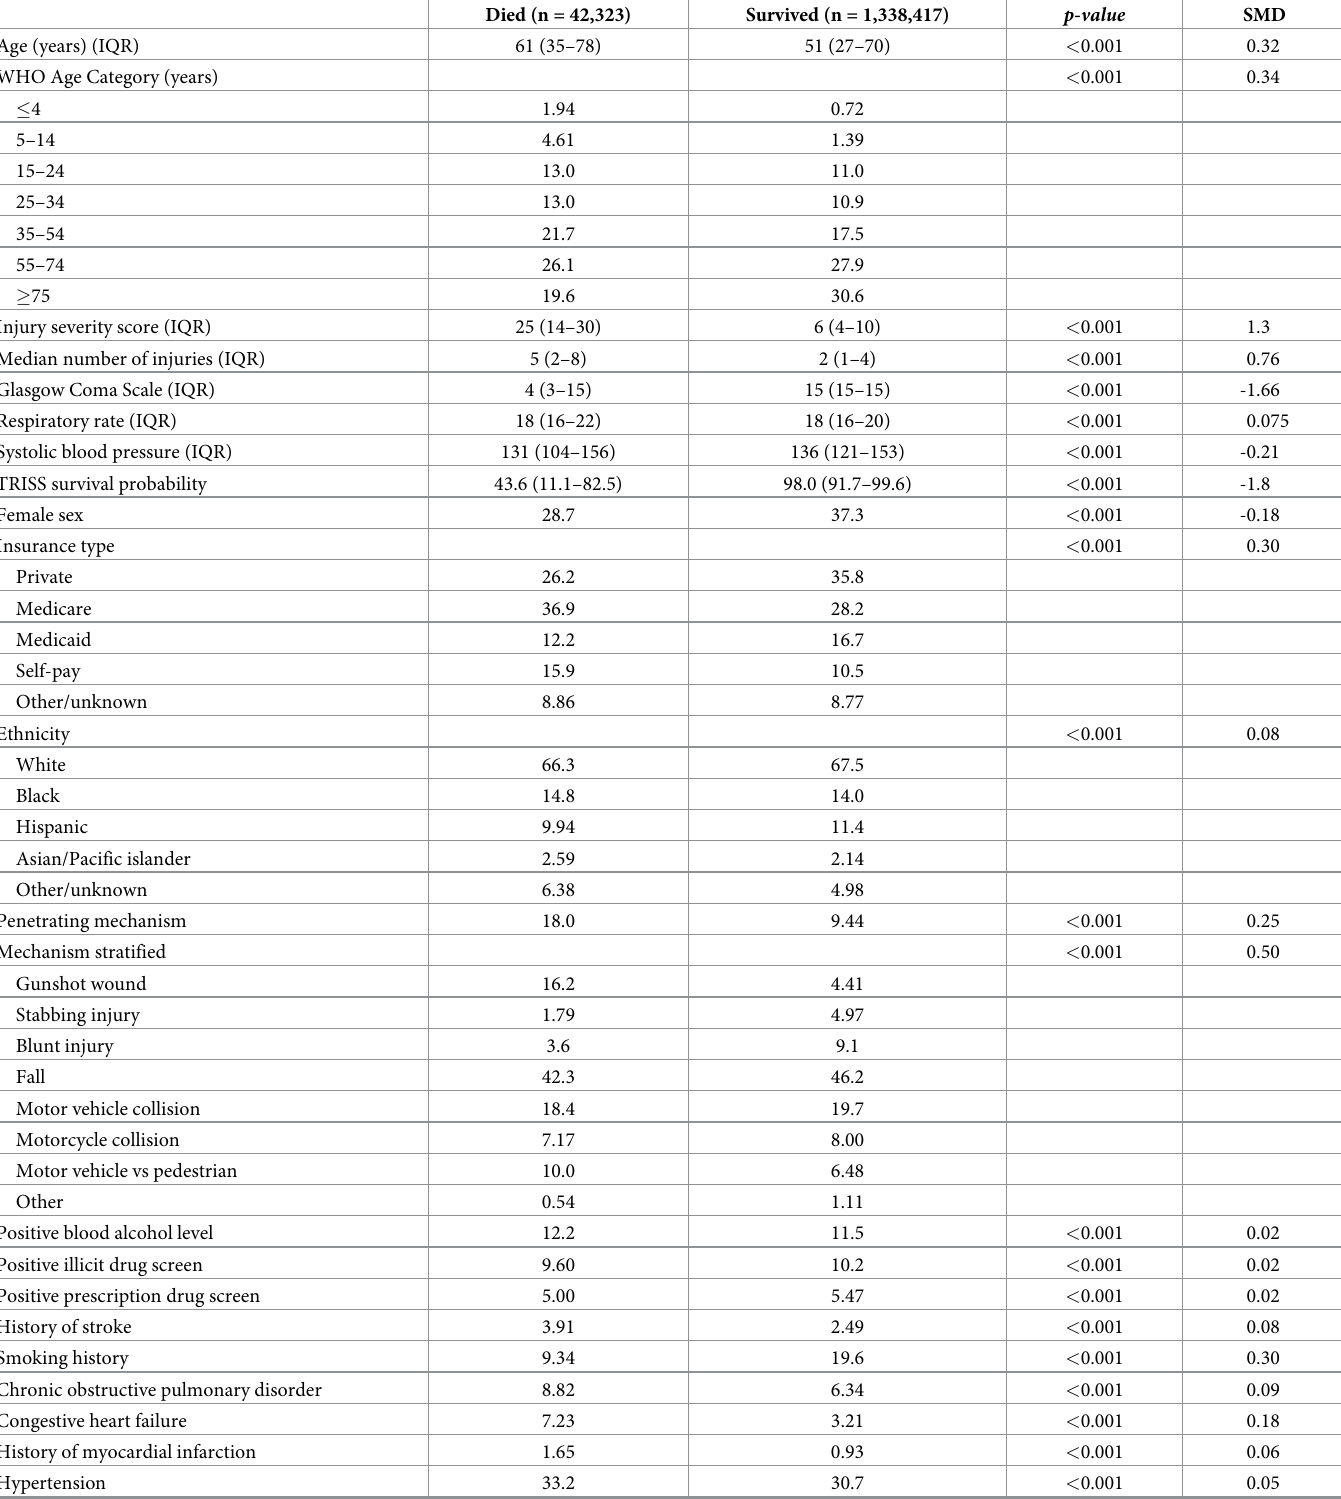
Table 1. Demographic comparison of those who died and those who